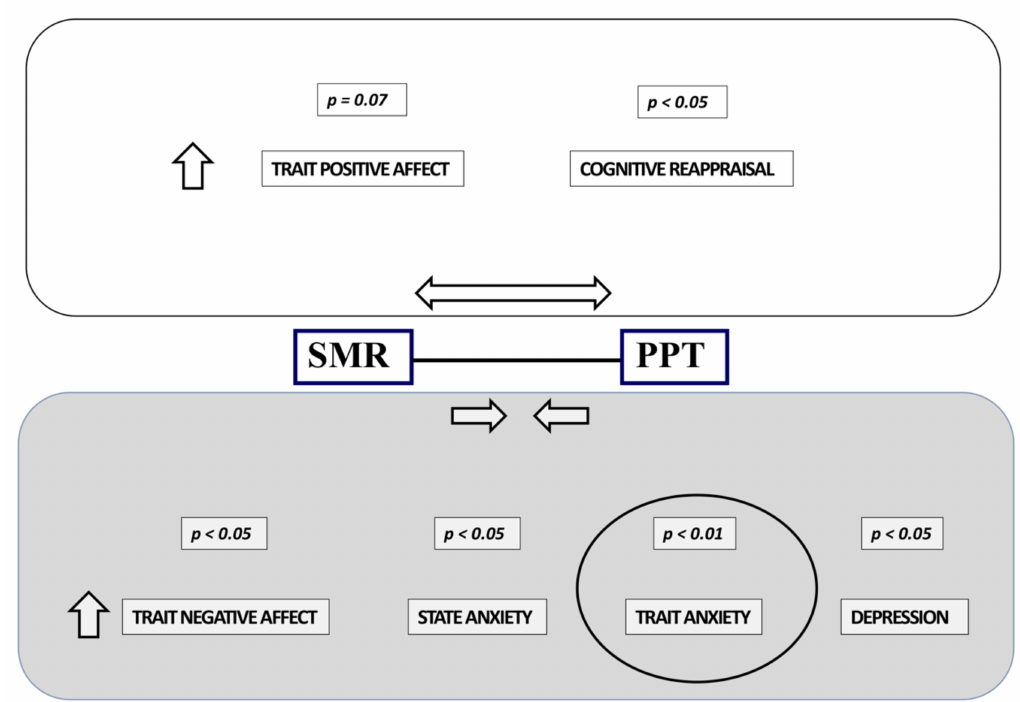
Figure 6. Correlation between pain facilitation and neuropsychological